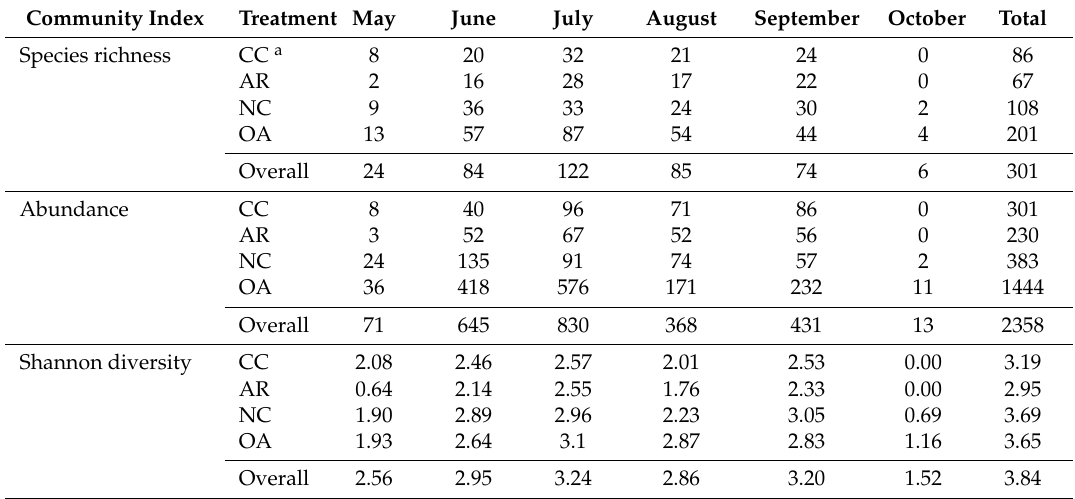
Table 2. Community indices of the moths in four different treatment stands at each sampling month. Community